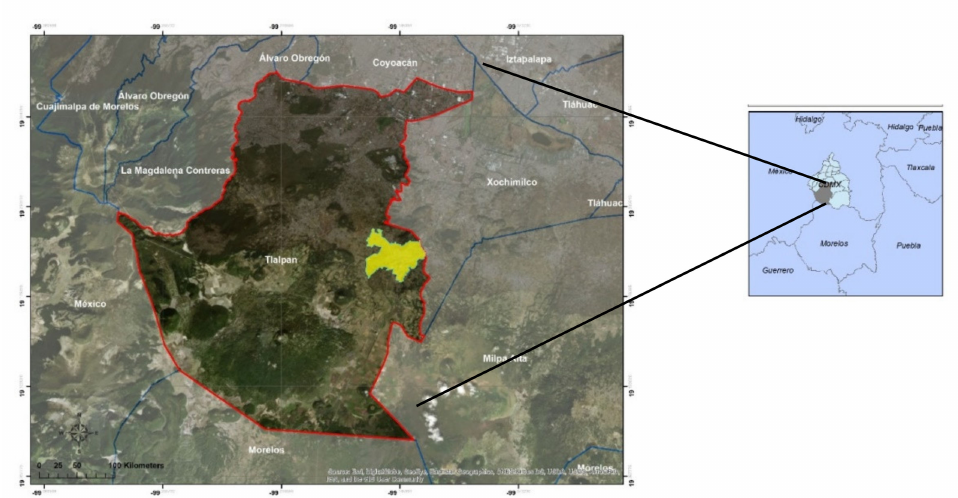
Figure 1. Research site was San Miguel Topilejo. Source: Elaborated by Magos-Hern á ndez in 2019 with information from INEGI